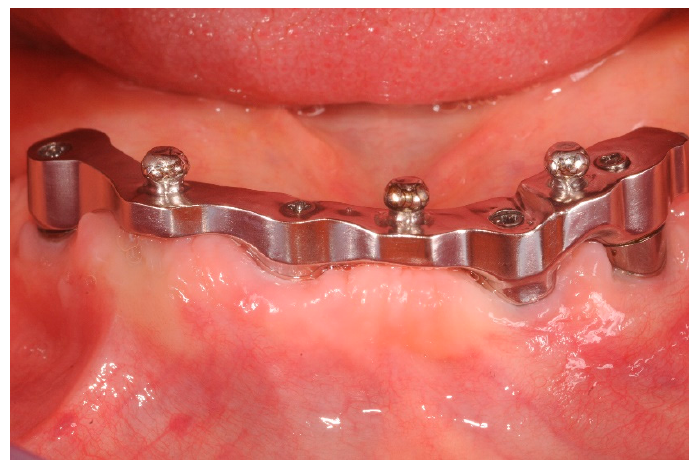
Figure 3. CAD/CAM implant-bar and the metal counterpart, front view at three years follow up. Figure 3. CAD / CAM implant-bar and the metal counterpart, front view at three years follow